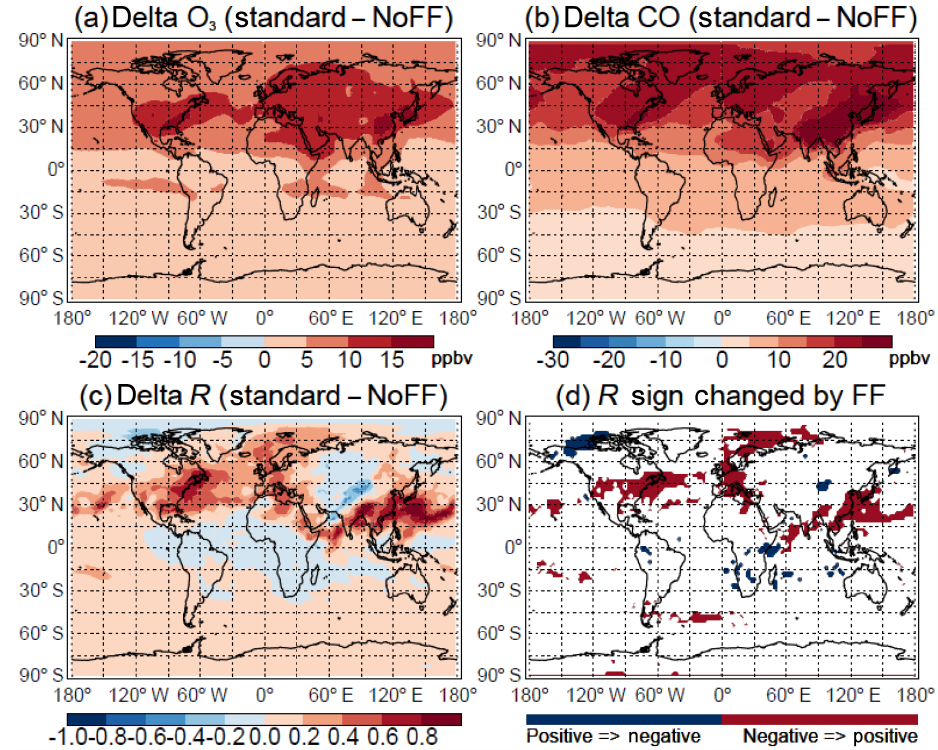
Figure 16. Sensitivity of O 3 , CO, and their correlations to fossil fuel (FF) emissions during July–August 2005. The plots show the mean differences in (a) O 3 , (b) CO mixing ratios (ppbv), and (c) O 3 –CO correlation coefficients ( R ) at 618hPa between the standard GMI/MERRA simulation and a simulation where fossil fuel emissions are suppressed (NoFF) in the model. Also shown in (d) are the areas with changed correlation signs. Results are calculated using 3-hourly model